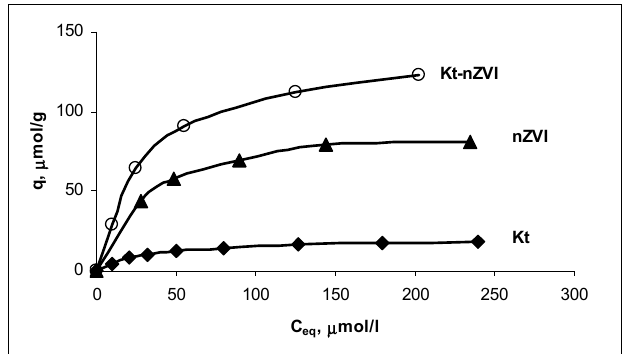
Figure 3. Sorption isotherms of U(VI) ions on pristine kaolinite and kaolinite-nZVI.